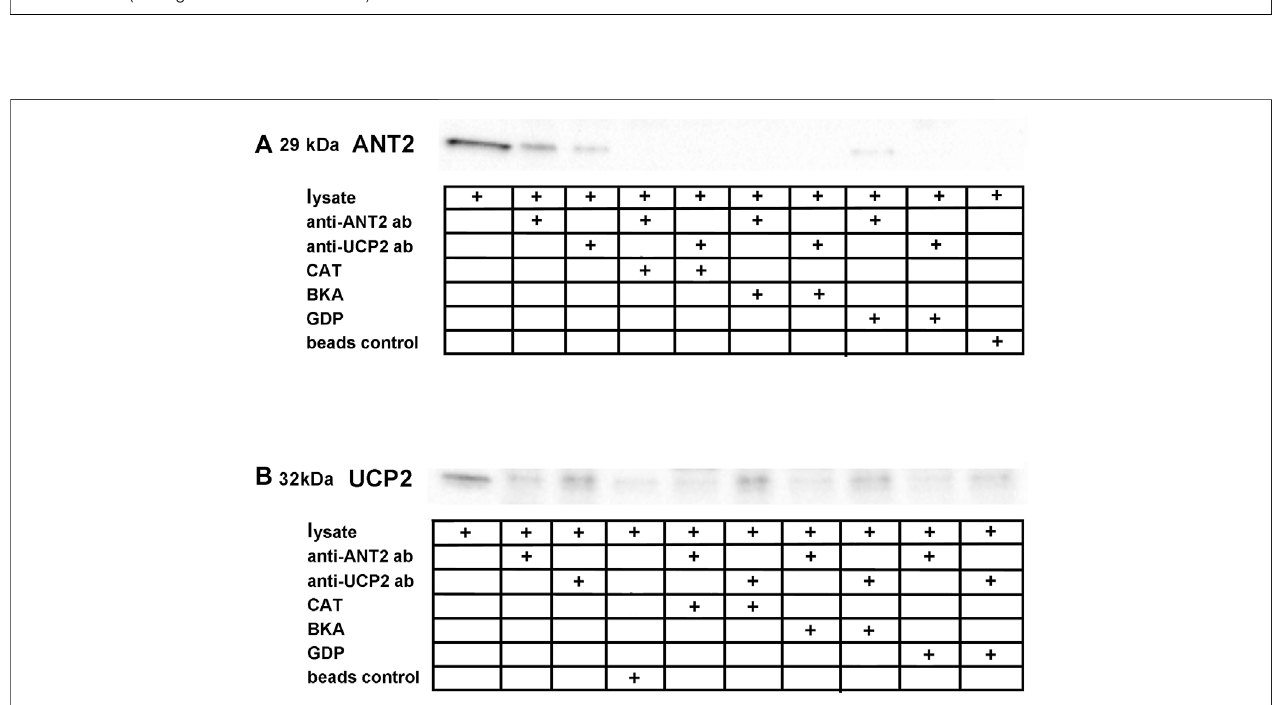
FIGURE 2 | Reciprocal co-immunoprecipitation was performed on lysate extracted from rat kidney cortex using magnetic beads coupled to anti-ANT2 and anti- UCP2 antibodies. (A) , ANT2 co-puri fi ed with UCP2 when using beads coupled to anti-UCP2 antibodies. ANT and UCP inhibitors interfered with the ANT2-UCP2 interaction. (B) , Similarly, UCP2 co-puri fi ed with ANT2 when using beads coupled to anti-ANT2 antibodies. The lane representing beads control revealed binding between the magnetic beads and UCP2, although to a smaller extent than in the lane representing the ANT2. The same inhibitor speci fi c interaction interference was observed, as the band densities did not exceed the apparent unspeci fi c binding between the beads and UCP2.